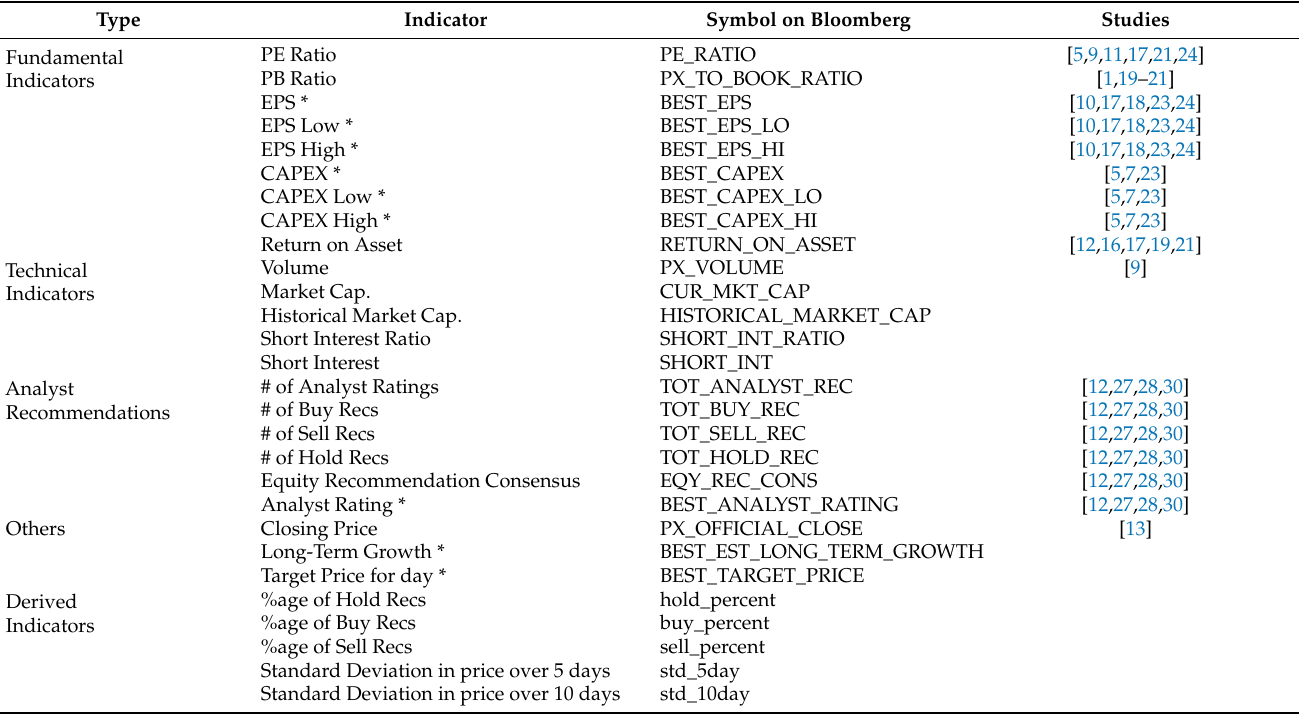
Table 1. Features and indicators used in this study. * BEst ratings (BEst EPS, BEst CAPEX etc) refer to ratings and numbers calculated and issued by Bloomberg’s internal division, Bloomberg Estimate.